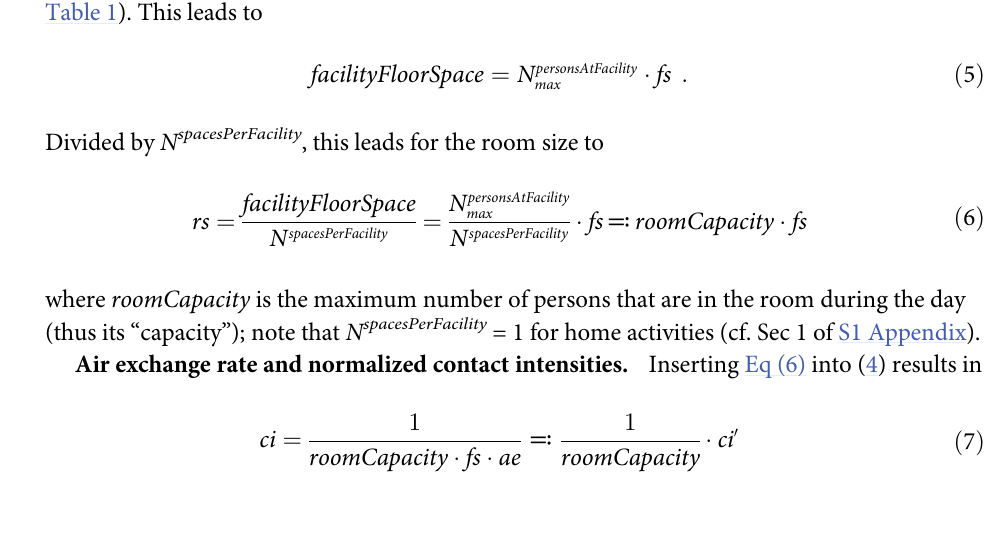
Table 1. Normalized contact intensities ci 0 , relative to the contact intensity at home, ci 0 activity